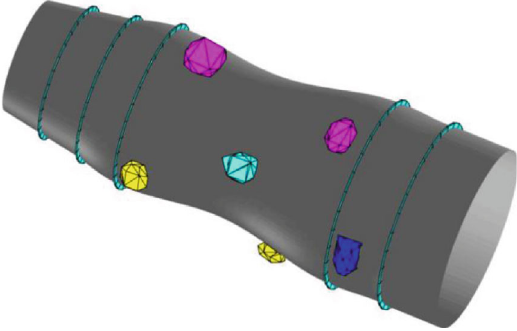
Figure 3: Obstacle model by convex hull in MATLAB.